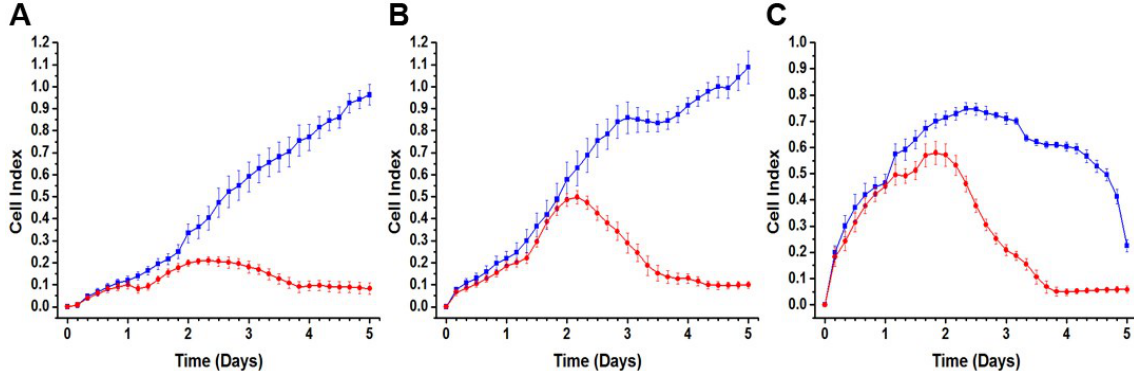
Figure 2. Cell Index vs. time for LUHMES cells: Initial cell density (cells/cm 2 ) A ) 30,000; B ) 60,000; C ) 120,000. Proliferating (blue) and differentiating (red) cells. Time in days after cell seeding. (Error bars: s.e.m., n =